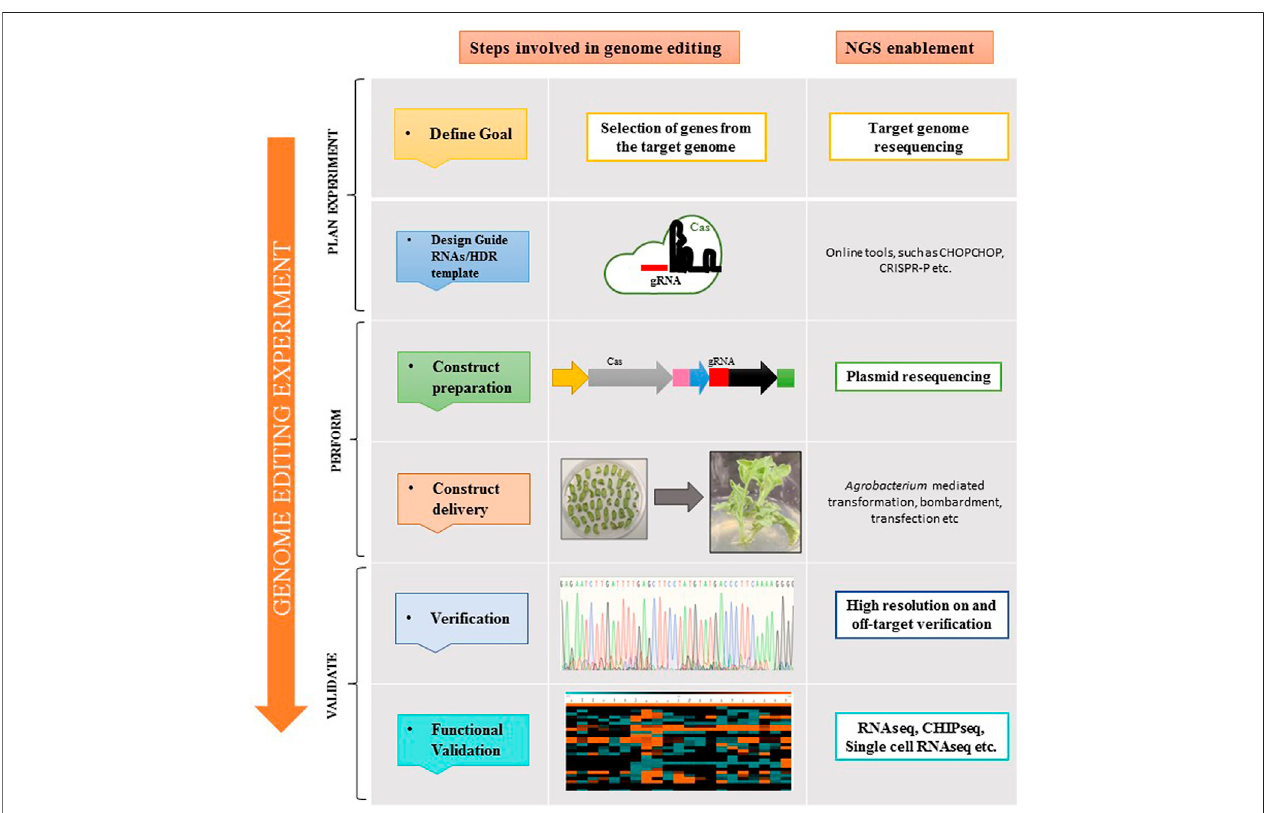
FIGURE 2 | Application of NGS at different steps of the plant genome editing work fl ow. The fi rst step in designing a CRISPR experiment is selecting the suitable CRISPR-associated(Cas)enzyme.Theprotospacer-adjacentmotif(PAM)sequencedetermineswhichCasenzymetousebecauseitascertainspotentialtargetsitesfor genome editing. In order to direct the Cas enzyme to the target site in the genomic DNA, guide RNA (gRNA) is optimally designed. For Cas9, the gRNA can be made either as a single guide RNA (sgRNA) or a 2-part guide RNA (containing crRNA and tracrRNA). To deliver Cas enzyme and guide RNA to cells, agrobacterium- mediated transformation, bombardment, transfection, etc. can be used. For determining the success of on-target editing and for examining off-target effects, NGS is highly recommended.